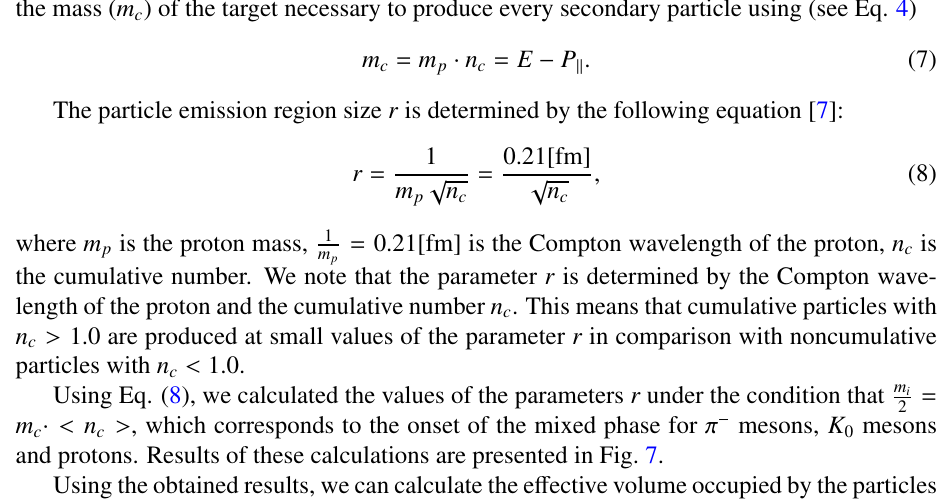
0 mesons and protons from